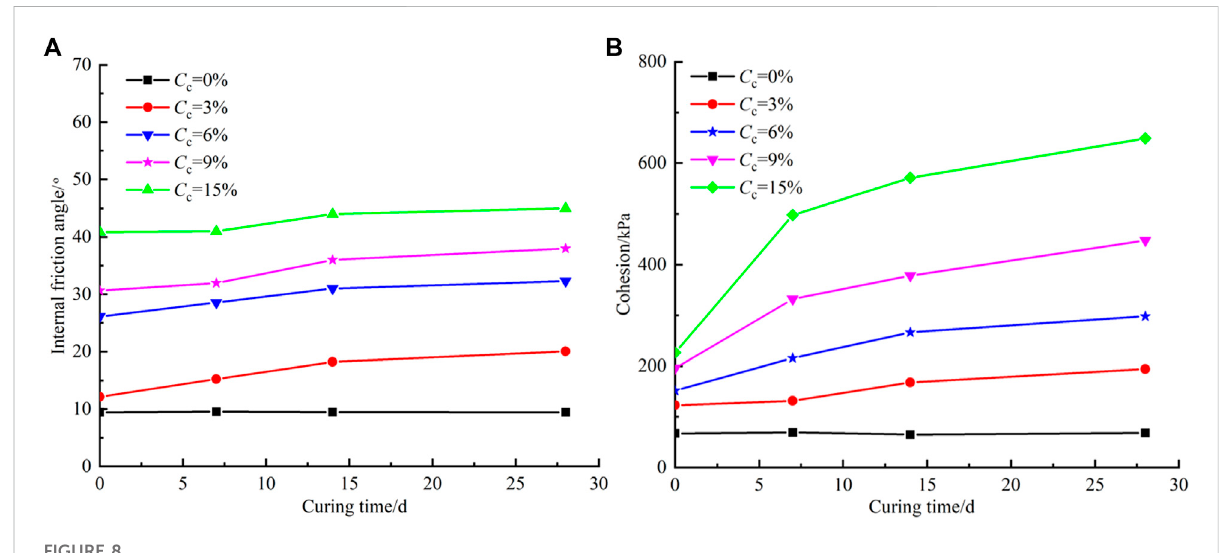
FIGURE 8 Shear strength parameters vs. cure time.